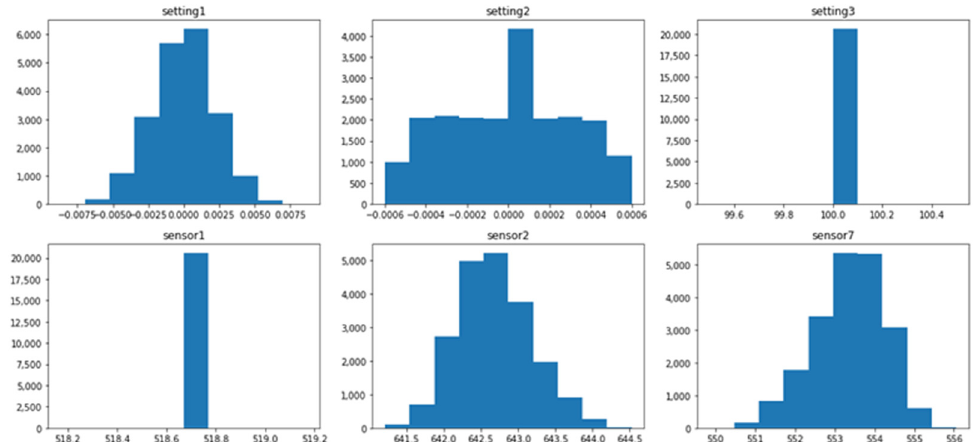
Figure 1. FD001_Train—distribution of selected variables.